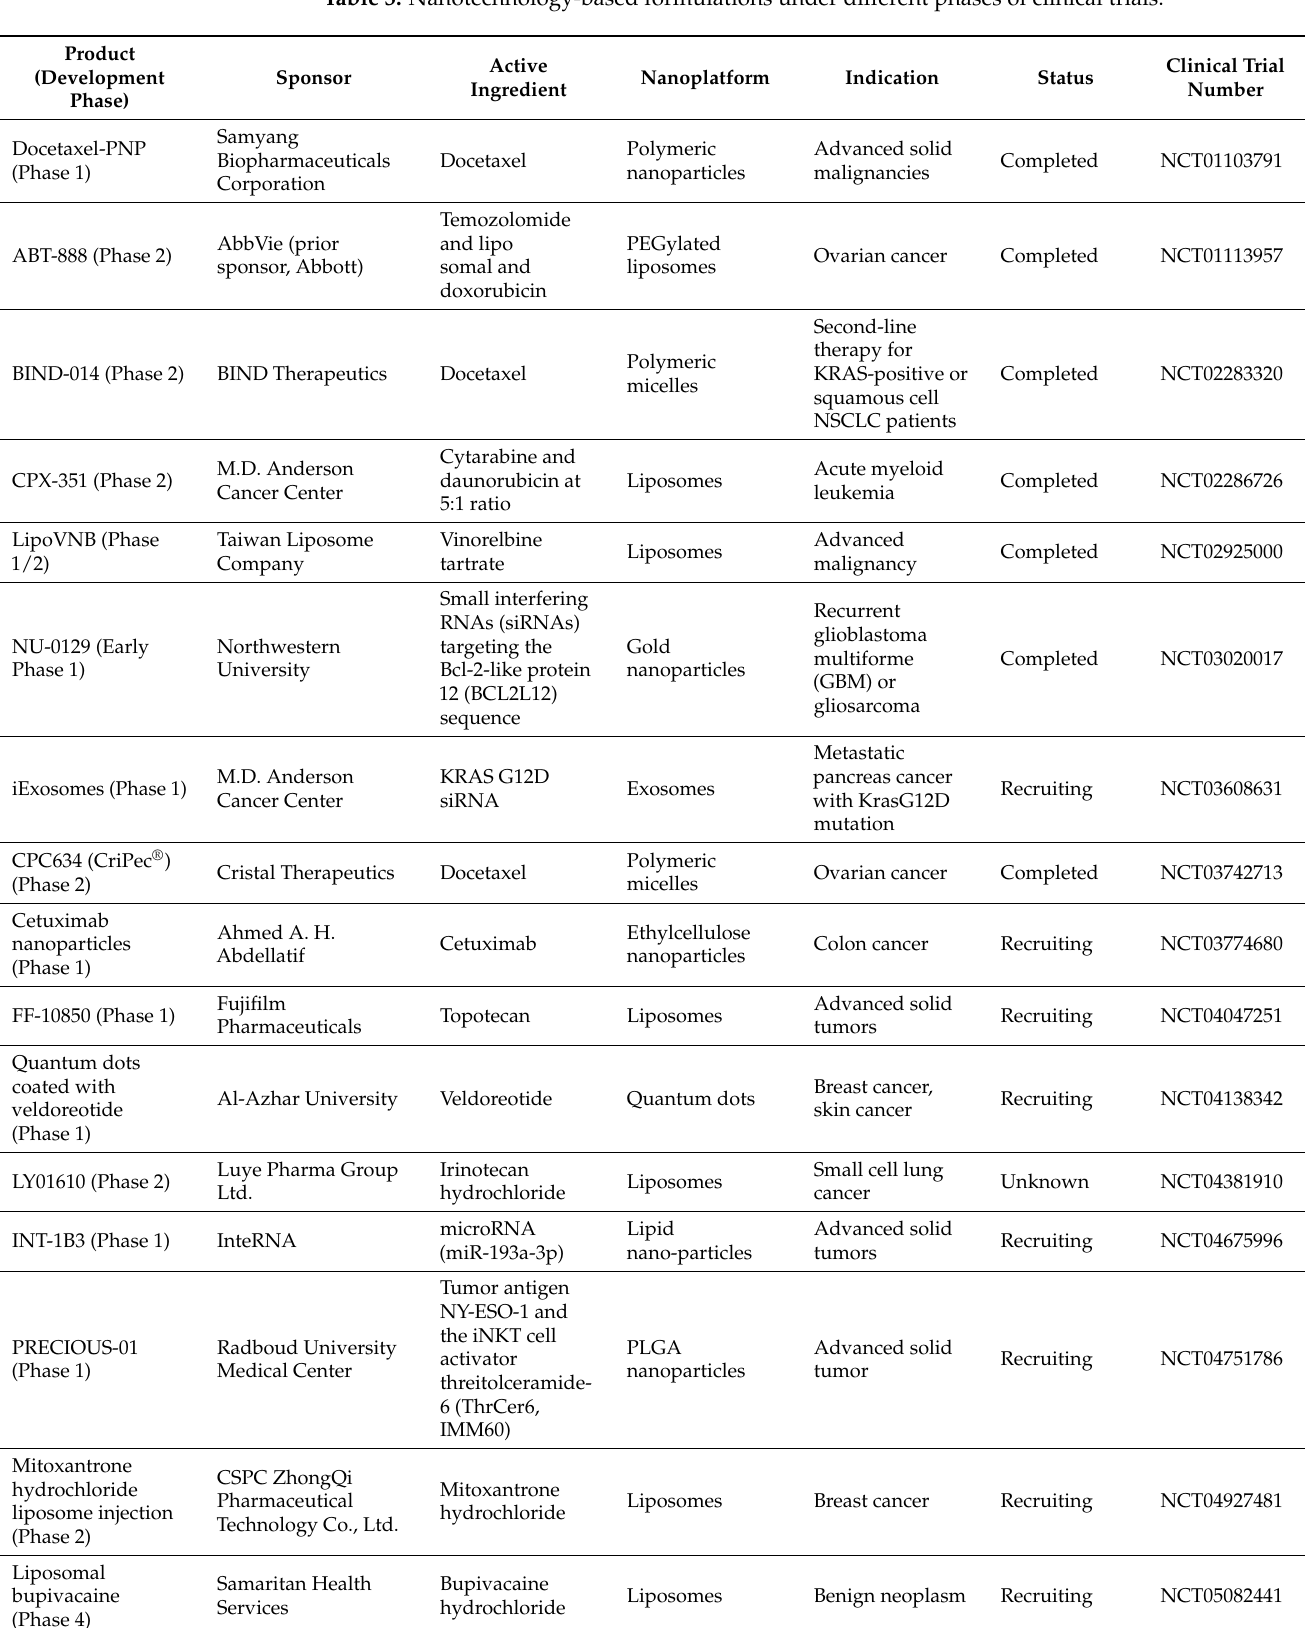
Table 3. Nanotechnology-based formulations under different phases of clinical